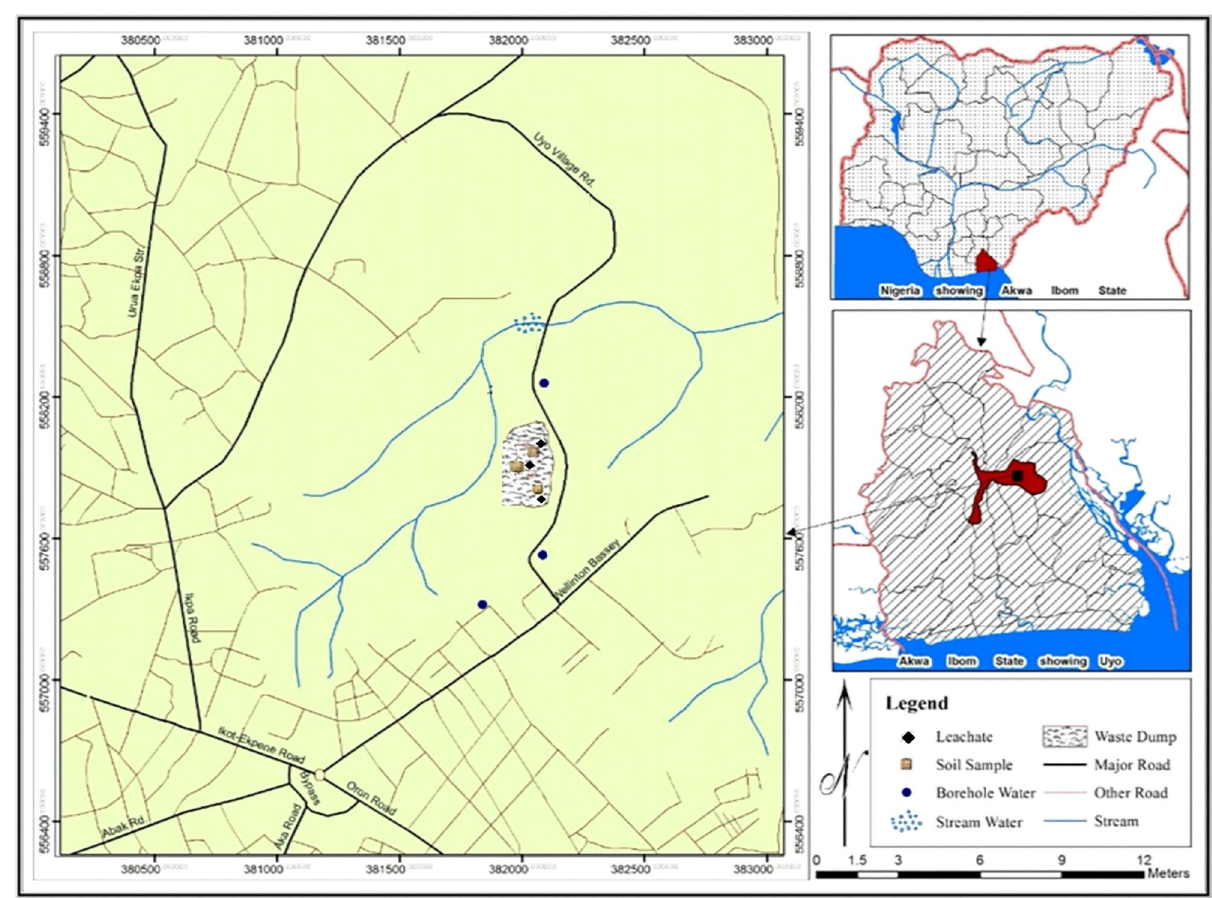
Figure 1. Map of Uyo Local Government Area showing the waste dumpsite and sample collection points (Source: AISMLS,